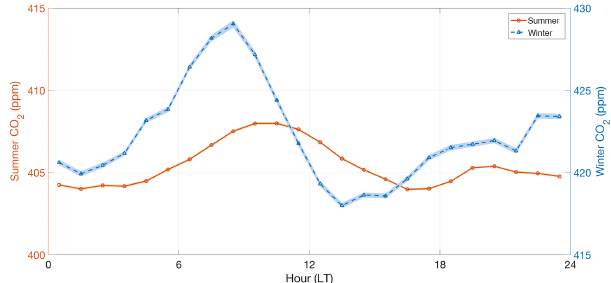
Figure 5. Hourly median values of the network-wide, regional CO 2 signals calculated for summer (orange) and winter (blue) periods in 2017. Lighter colored curves indicate the standard error; note the difference in y